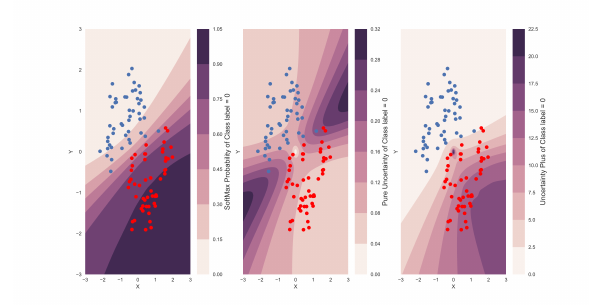
Figure 4. Comparison of Three Prediction Related Uncertainty Indexes on a Binary Classifier. In this figure, three different means of crafting uncertainty boundary for obtaining classification prediction on a simple binary classification problem, i.e., two classes are separated by blue and red, is